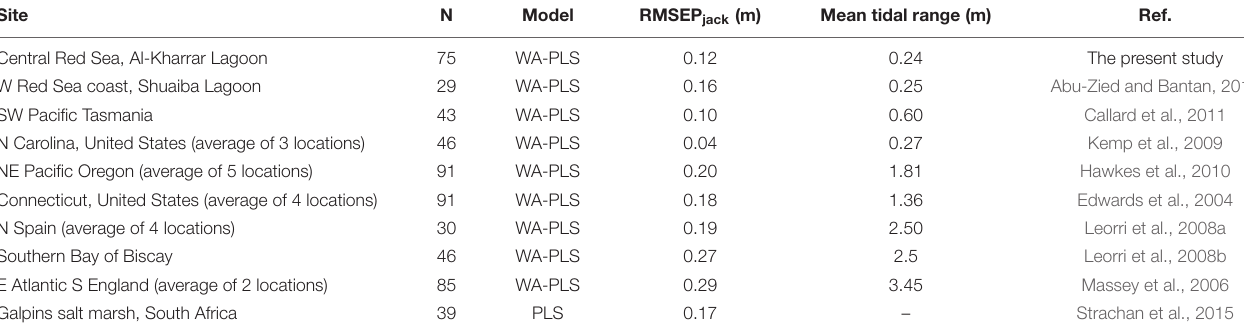
TABLE 5 | Comparisons between our results with modern foraminiferal datasets from other intertidal/salt marshes of the world. Site N Model RMSEP jack (m) Mean tidal range (m) Ref.